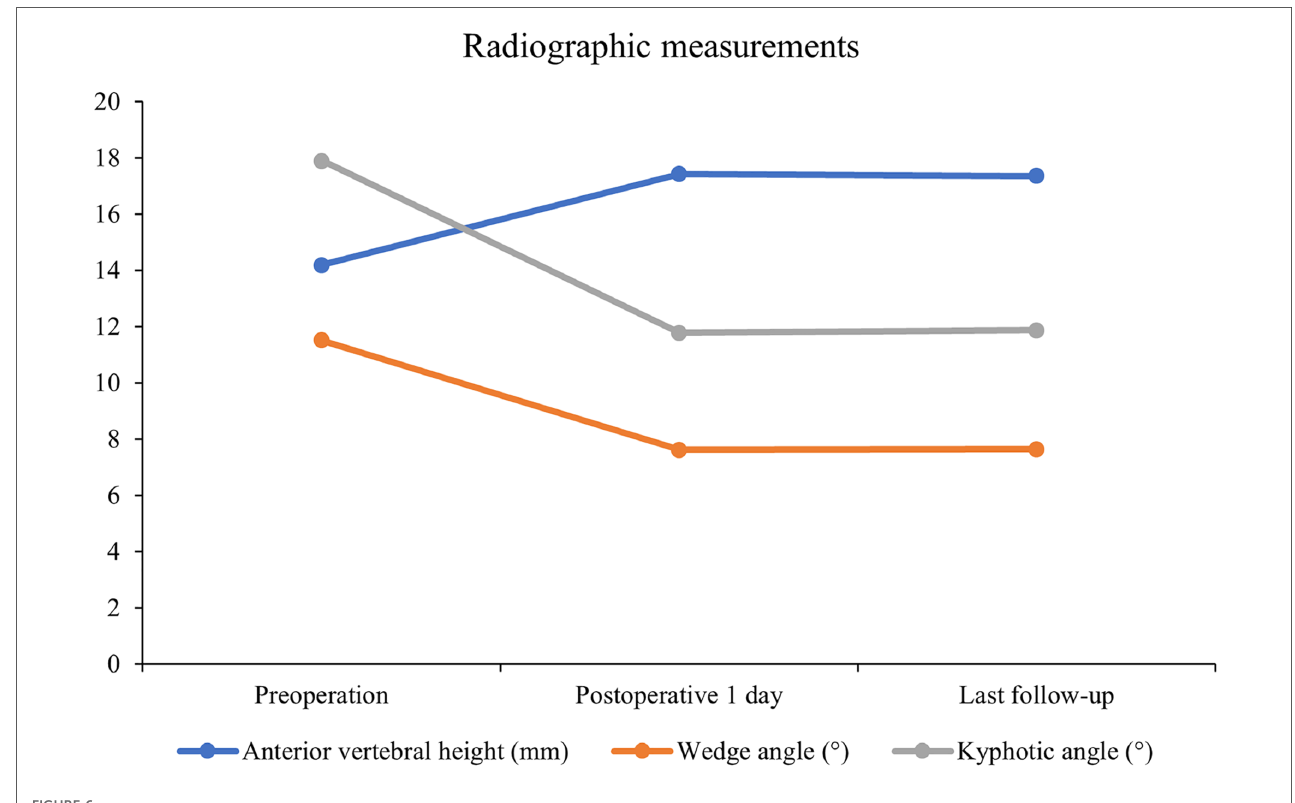
FIGURE 6 Line charts for radiographic measurements